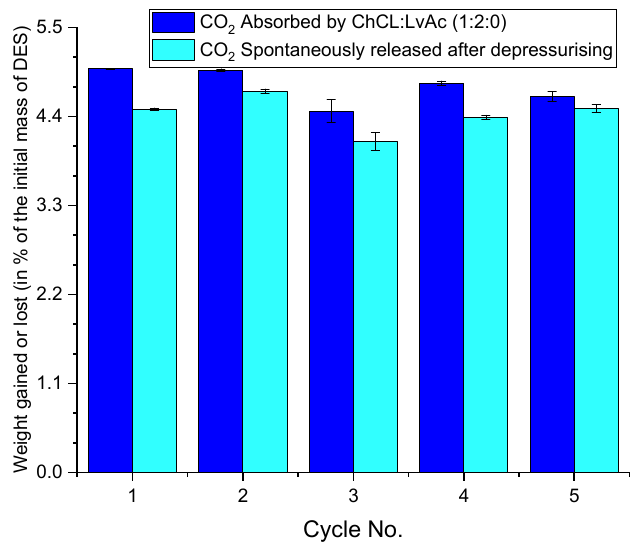
Figure 16. Weight gained through CO 2 absorption for 5 cycles at 25 °C and CO 2 released spontaneously after depressurisation. Experiments carried out with ChCl:LvAc (1:2:0) at 25 °C and 250 rpm.